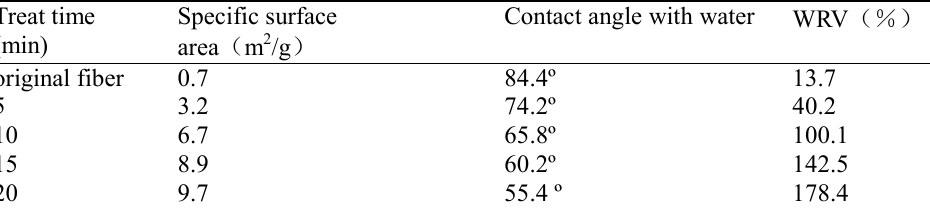
Table 1. Properties of the fibrillated fiber.